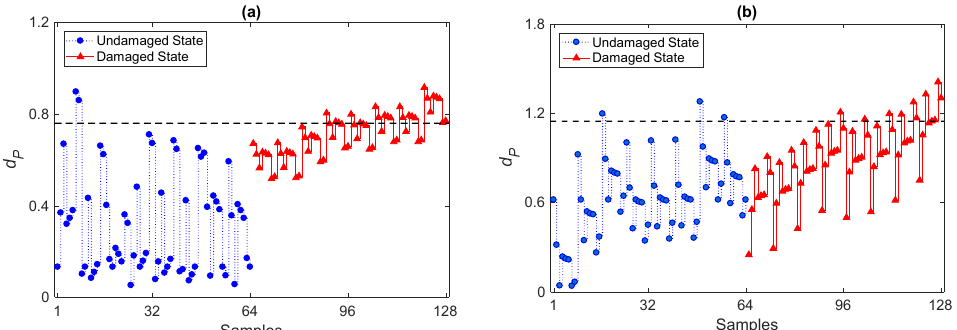
Figure 8. Evolution of the distance value d P by the proposed PKLD-NN method and by the CBFE algorithm, using models ( a ) ARMA(15,15) and ( b ) ARMA(5,5).